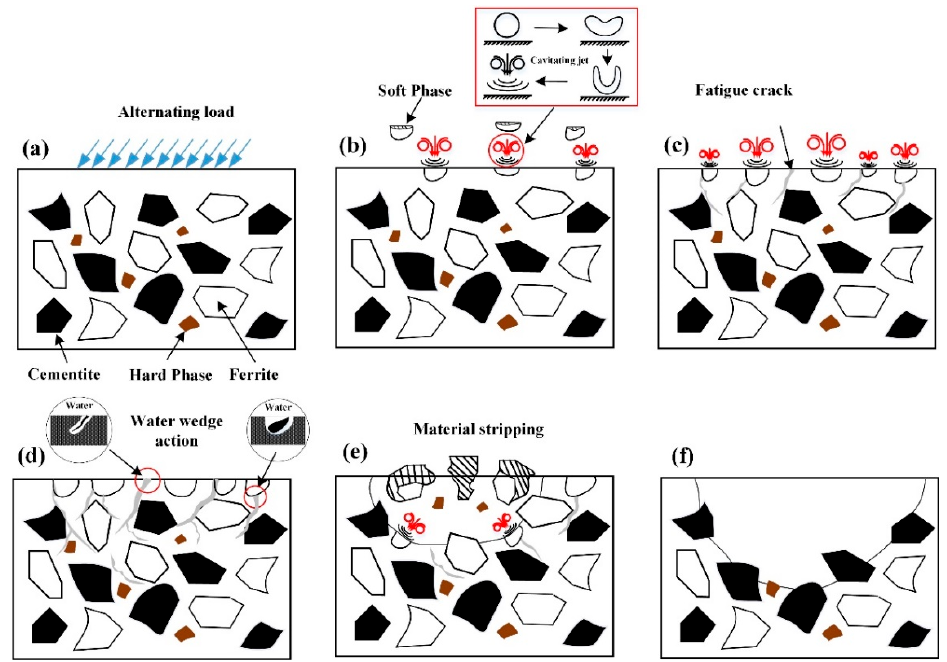
Figure 14. Grade A ship steel jet erosion and peeling mode. ( a ) Alternating load ( b ) Stripped soft phase ( c ) Fatigue crack ( d ) Water wedge action ( e ) Stripped hard phase ( f ) failure morphology